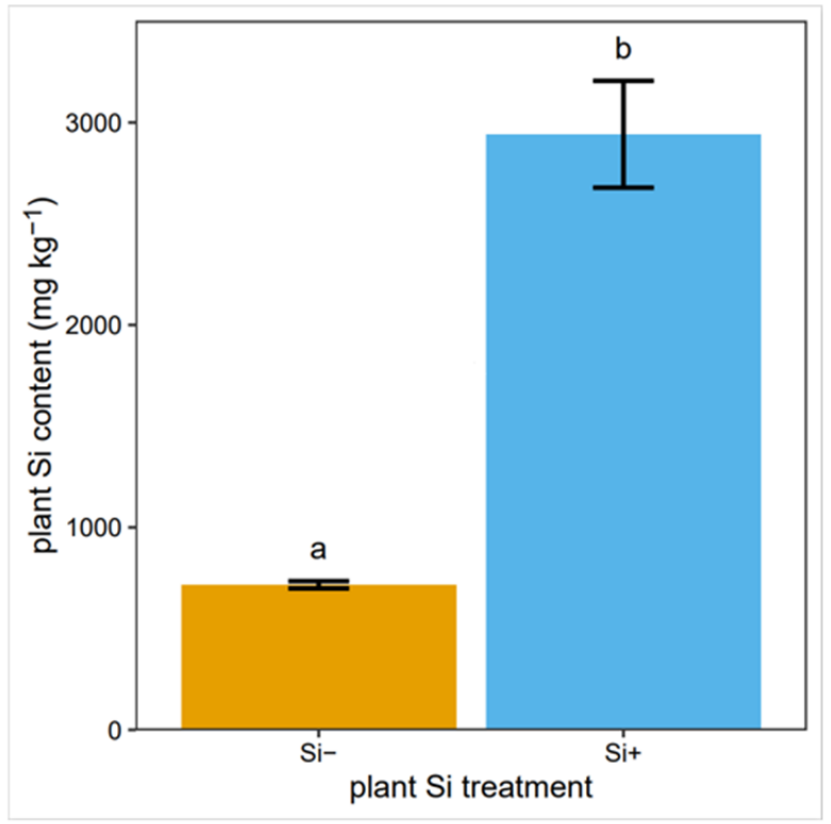
Figure 2. Silicon (Si) content in maize leaf tissue 1 week following application. Si − (orange bar) = silicon deprived plants treated with potassium chloride; Si+ (blue bar) = silicon supplemented plants treated with potassium silicate. N = 3, error bars = standard error. Silicon content between Si − and Si+ is significantly different ( t = − 8.42, p = 0.013). Letters ‘a’ and ‘b’ indicate significant differences between the